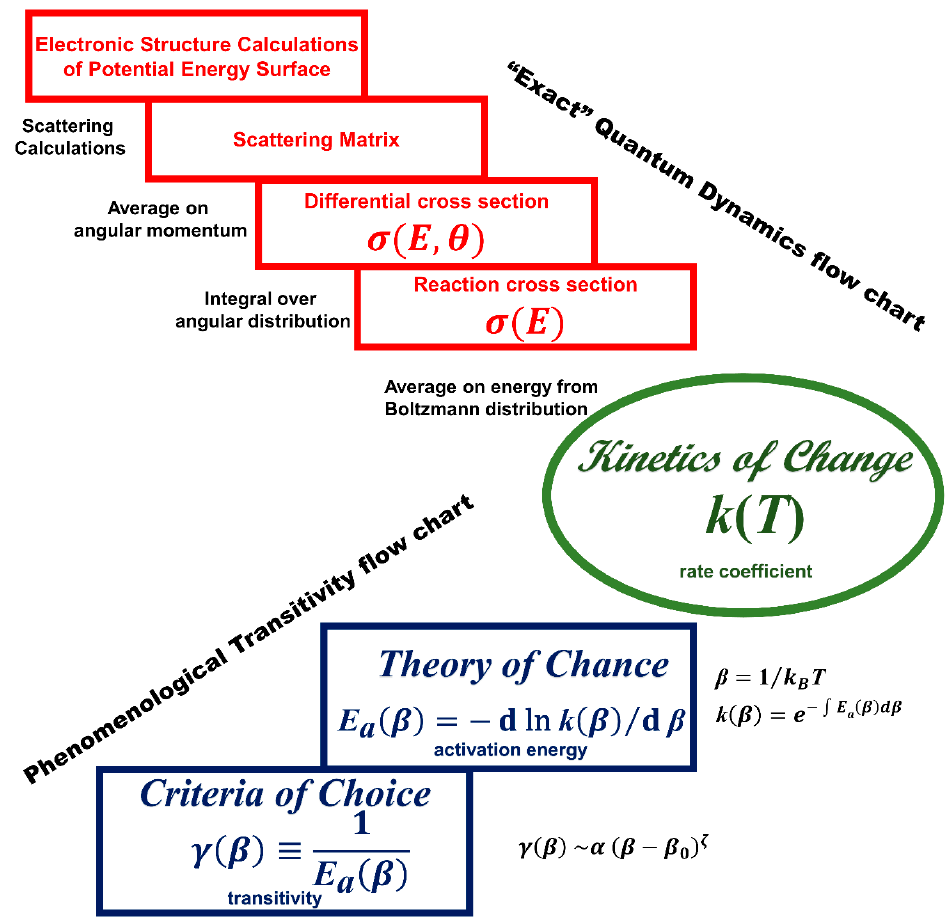
Figure 1. Stepping stones for the sequence (in red) from quantum chemical calculations to theoretical (“exact”) rate coefficients (downward along upper part of the chart, see also [2]); and the sequence (in blue) from the transitivity function γ ( β ) to the phenomenological rate coefficients (upward in the lower part of the chart). Models for γ ( β ) are discussed in [3] and further in Sections 3 and 4. Here α = 1/ ε ‡ , the reciprocal of Eyring activation energy for β 0 = 0 in the asymptotically high temperature of the thermodynamic limit (Section 2.2). The critical exponent ξ generalizes the integer n in reference [3] and will be related (see Figure 5) to classes of universal